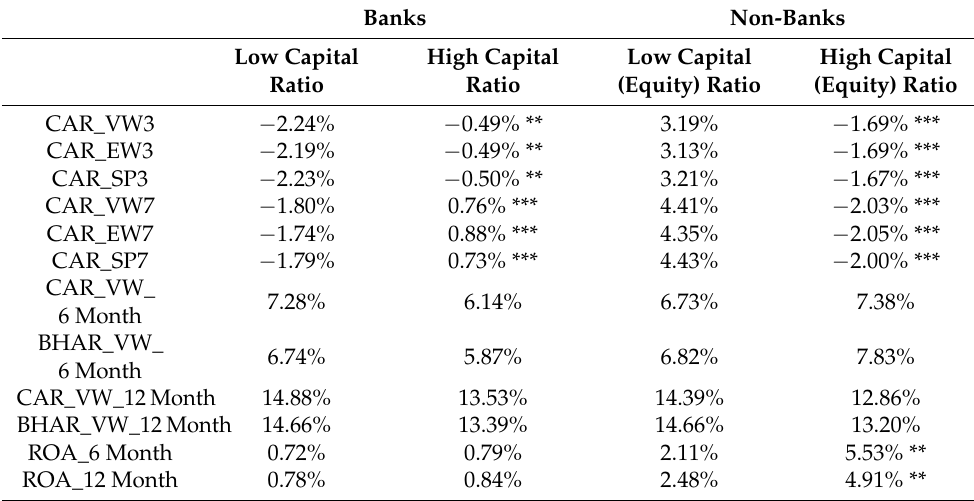
Table 3. Capital Ratio, Abnormal Returns, and Performance. This table compares mean an- nouncement period abnormal returns, longer-term post-announcement abnormal returns, and post- acquisition performance between lower-than-median capital ratio banks versus higher-than-median capital ratio banks (left 2 columns), and between lower-than-median equity ratio non-banks versus higher-than-median equity ratio non-banks (right 2